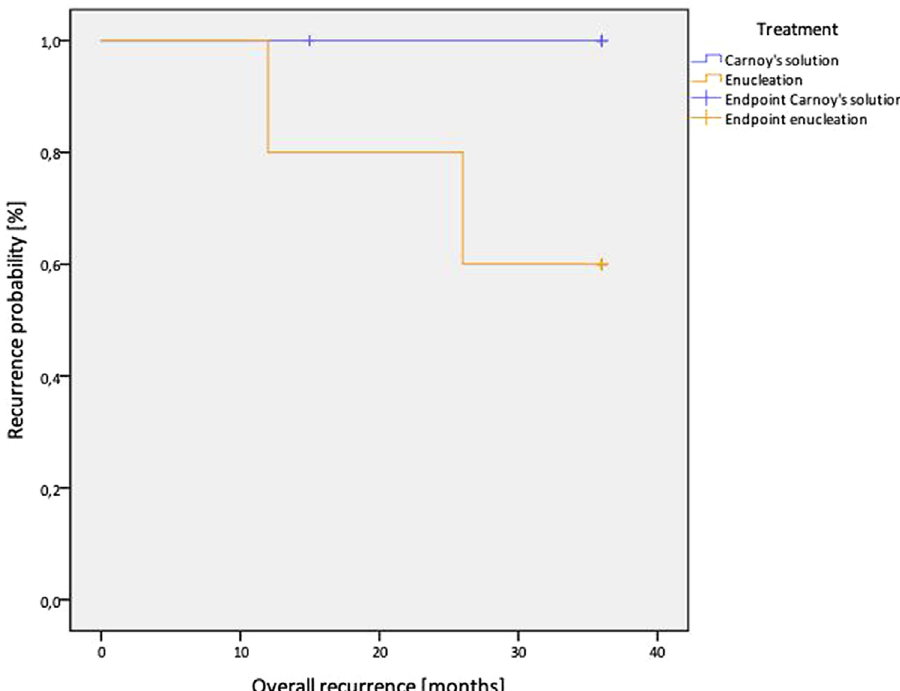
Fig. 5. Kaplan-Meyer test for the recurrence of OKCs with simple enucleation or enucleation with Carnoy ’ s solution